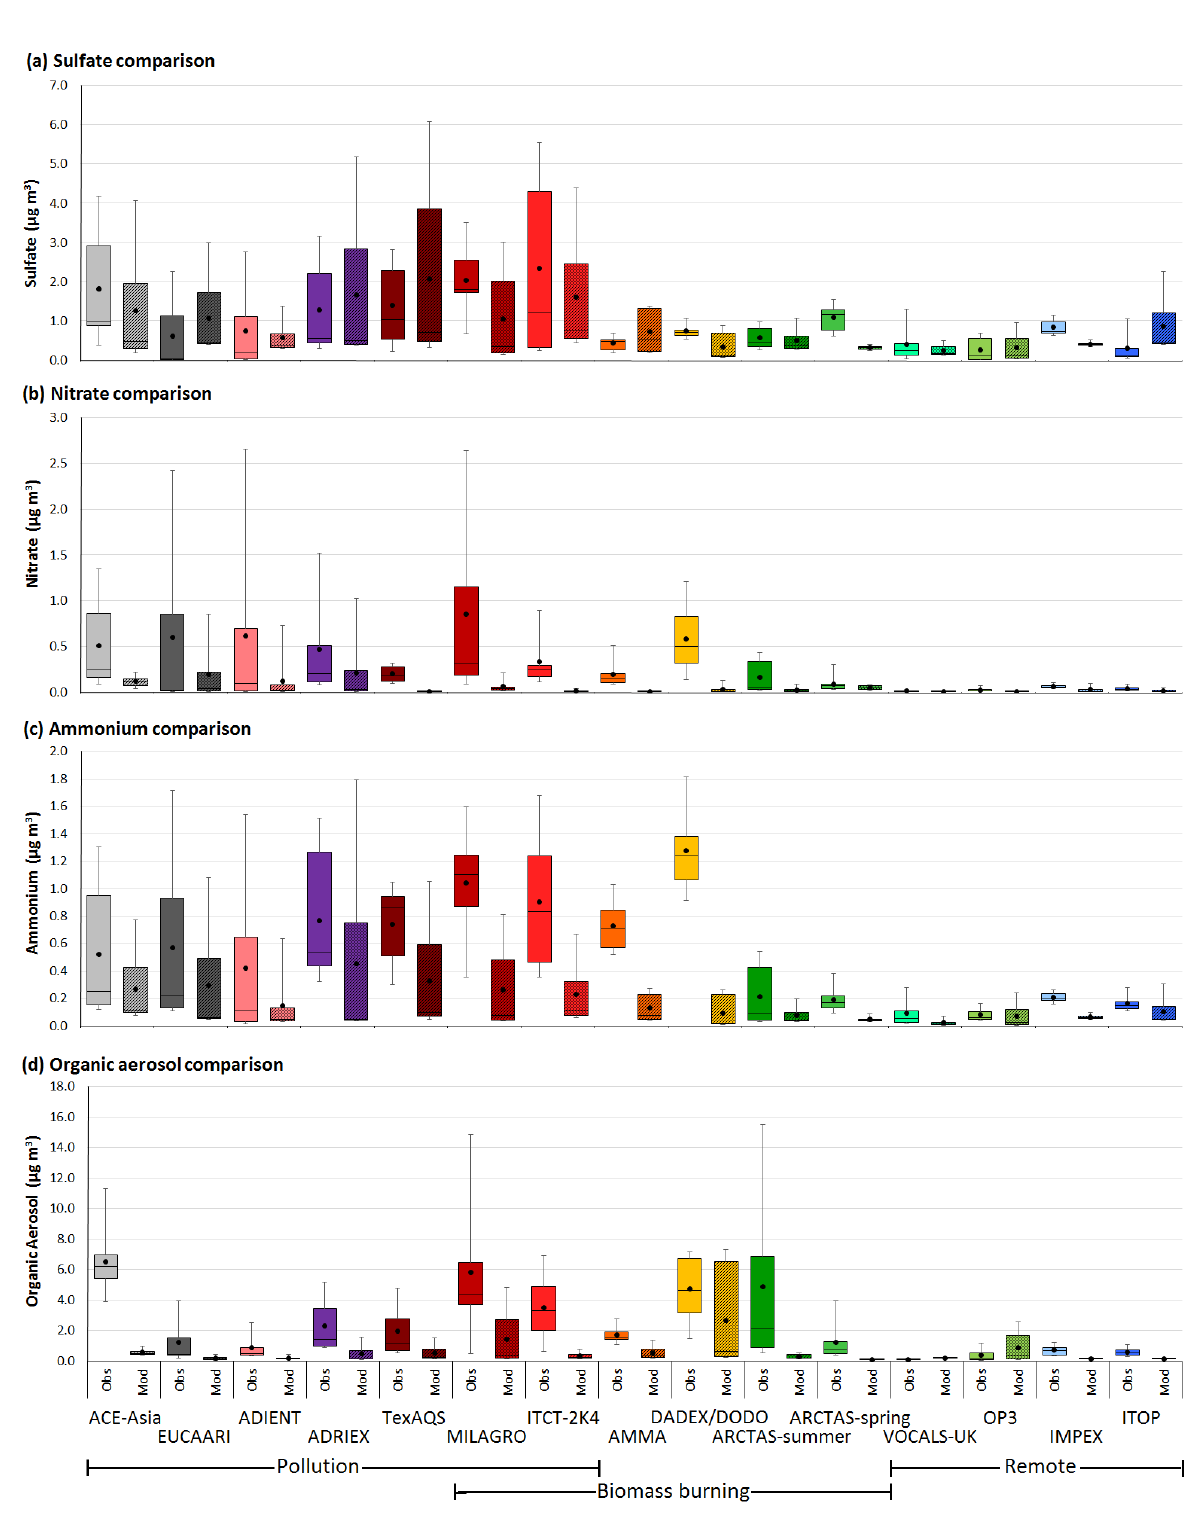
Figure 1. Comparison of observed (Obs) and simulated (Mod) (a) sulfate; (b) nitrate; (c) ammonium, and (d) organic aerosol mass concen- trations. Observations are from airborne field campaigns compiled by Heald et al. (2011). Mean values are represented by black dots, median values as shown by horizontal lines, while boxes denote the 25th and 75th percentiles, and whiskers denote the 5th and 95th percentile